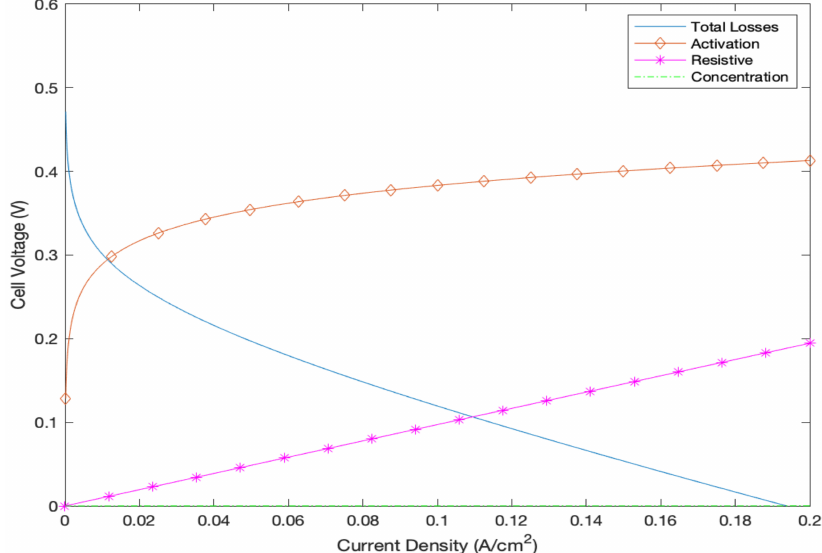
Figure 13. Polarization curve with loss